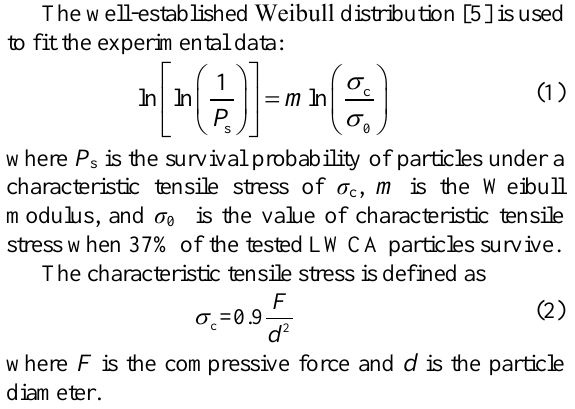
Fig. 5. Relationship between loading stiffness and LWCA particle size under uniaxial compression